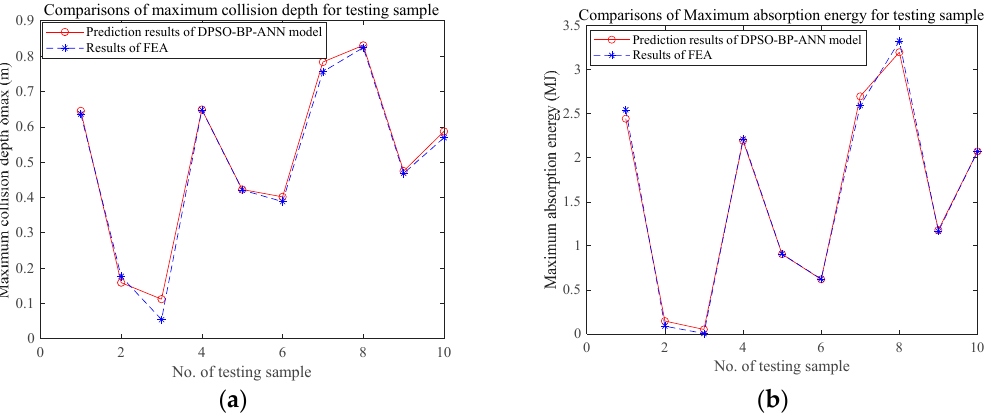
Figure 8. Comparisons for training sample. ( a ) Comparisons of maximum collision depth, ( b ) comparisons of maximum absorption energy. Table 8. Prediction results of DPSO-BP-ANN model for testing samples.